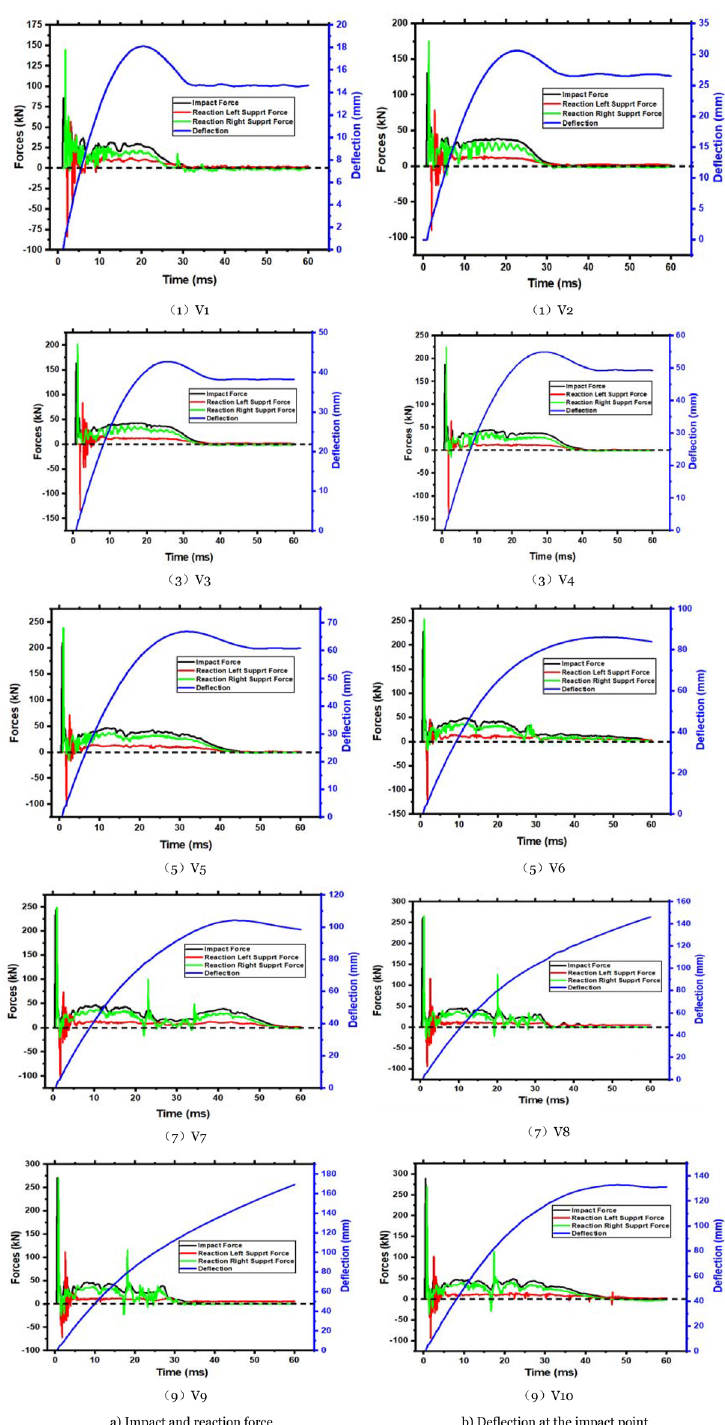
Figure 17. Forces and deflection time history curves of members under different impact